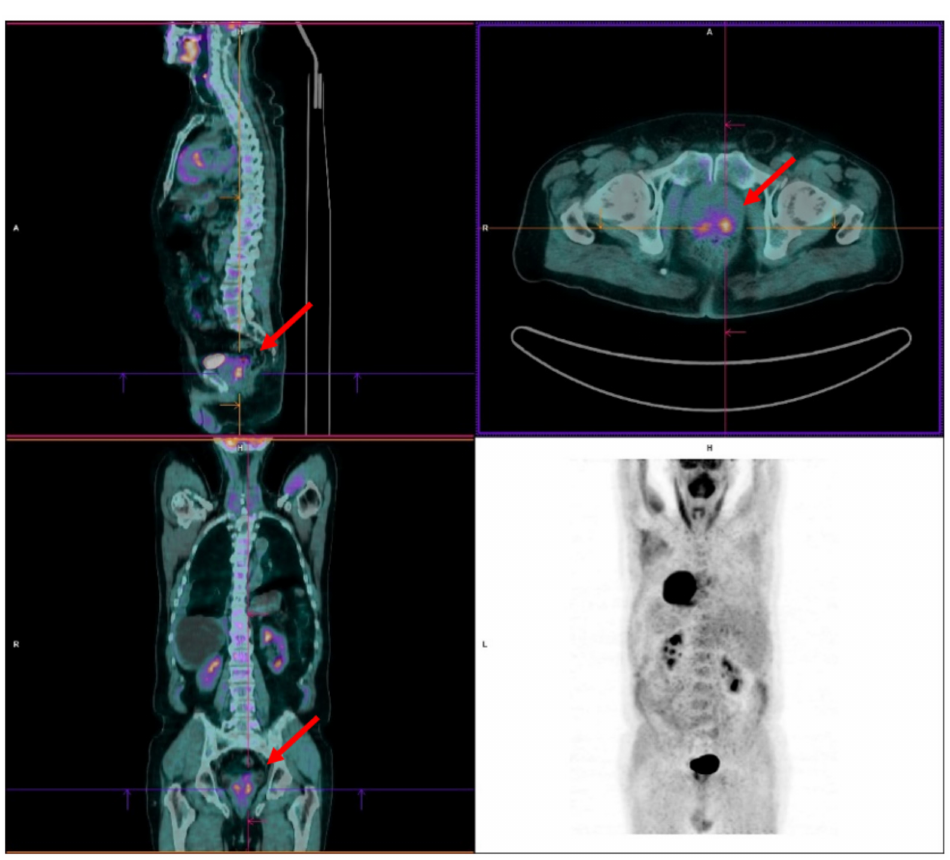
Figure 2. Incidentally increased tracer uptake in two areas (red arrows) of the posterior lobe of the prostate gland resulting in PCa at